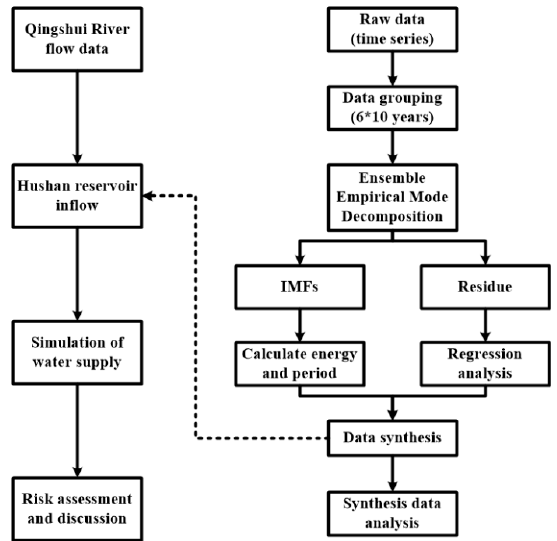
Figure 1. Research flowchart. EMD, empirical mode decomposition components.